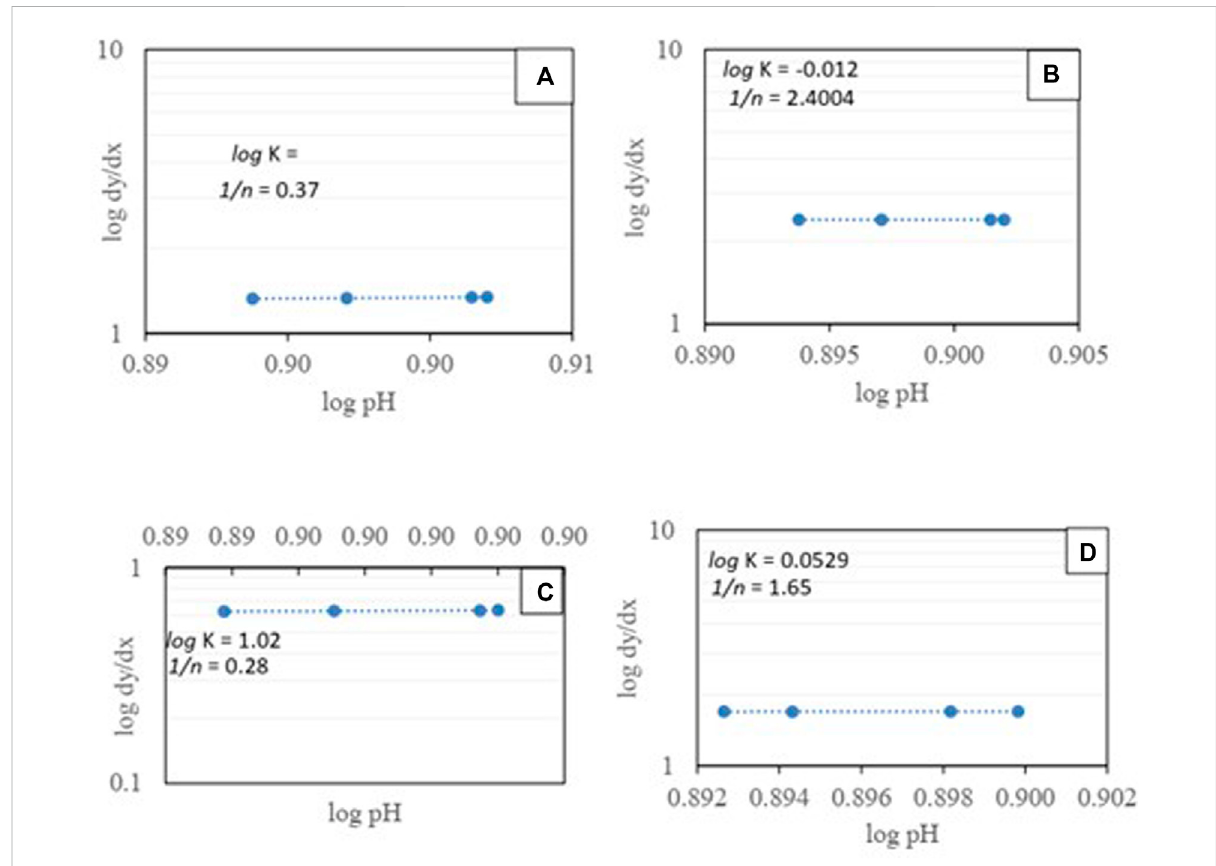
FIGURE 7 Adsorption isotherm for heavy metal removal from the solid phase i:e soil using biochar as adsorbent [ (A) : 1% BC and Lead; (B) : 1% BC and Cadmium; (C) : 5% biochar and lead and (D) : 5% biochar and cadmium].